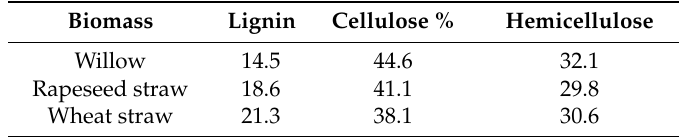
Table 1. Lignin, hemicellulose, and cellulose contents in raw biomass. Biomass